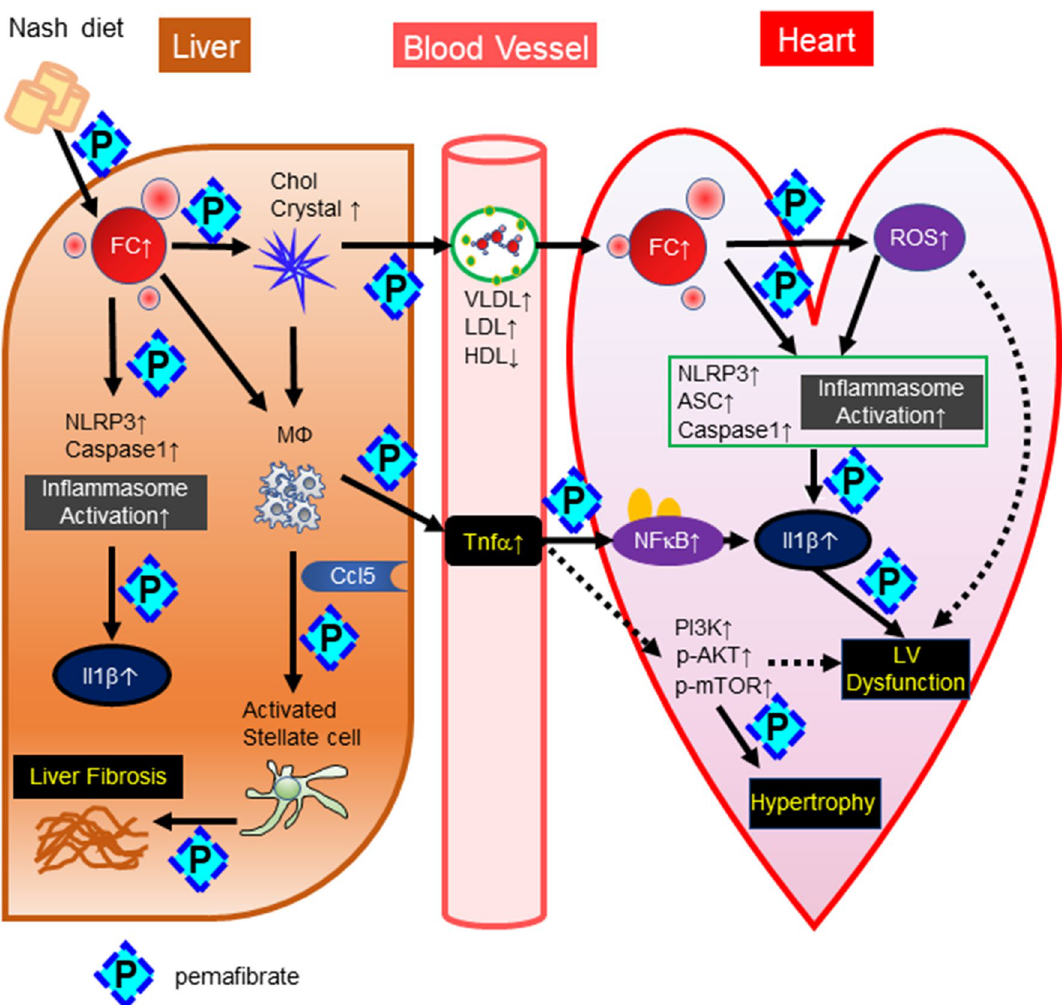
Figure 7. Mechanisms of steatohepatitis-related cardiomyopathy and the effects of pemafibrate. Cholesterol absorbed from the NASH diet is first taken up by the liver. Some of the free cholesterol in the liver becomes cholesterol crystals, which are taken up by macrophages and hepatocytes and lead to the production of IL-1β. In addition, macrophages produce Ccl5, which activates stellate cells and causes liver fibrosis. Free cholesterol in VLDL and LDL is taken up into the myocardium, where it activates macrophages and inflammasomes of myocardial cells, induces IL-1β production, and causes LV hypertrophy and dysfunction. Furthermore, ROS generated by an increase in free cholesterol are also considered to be involved in cardiac dysfunction. Pemafibrate reduces the level of free cholesterol in the liver and inhibits the production of cholesterol crystals, thereby suppressing the activity of inflammasomes and inhibiting the development of steatohepatitis. As a result, serum VLDL, LDL, and TNF-α were reduced and HDL was increased. Free cholesterol in the myocardium was reduced and inhibited myocardial damage via suppression of myocardial inflammasome